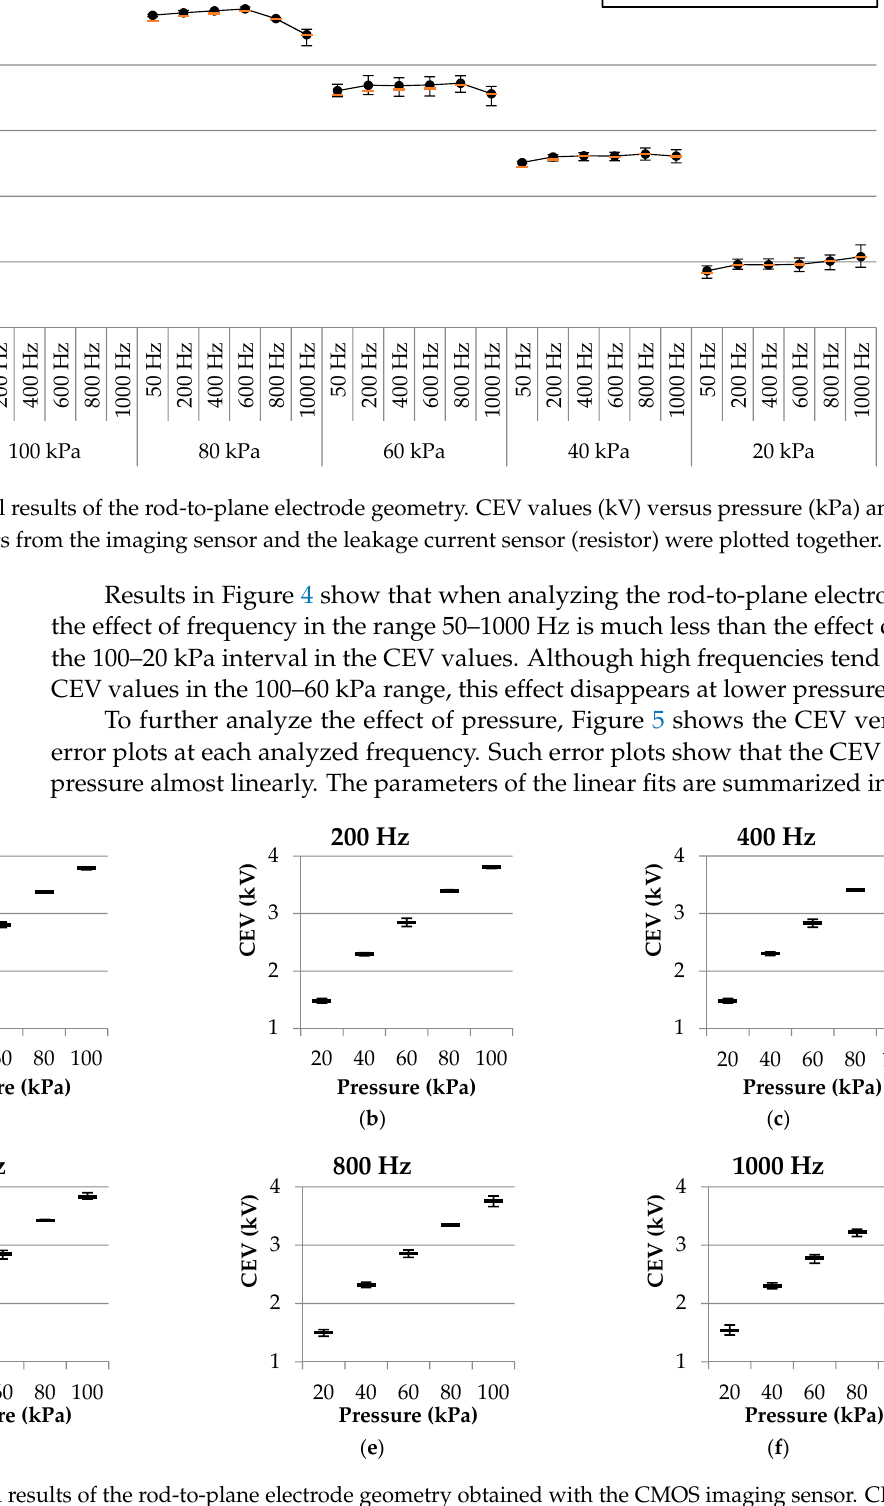
Figure 5. Experimental results of the rod-to-plane electrode geometry obtained with the CMOS imaging sensor. CEV values (kV) dispersion plot of the three measurements at each point versus pressure (kPa). ( a ) 50 Hz; ( b ) 200 Hz; ( c ) 400 Hz; ( d ) 600 Hz; ( e ) 800 Hz; ( f ) and 1000